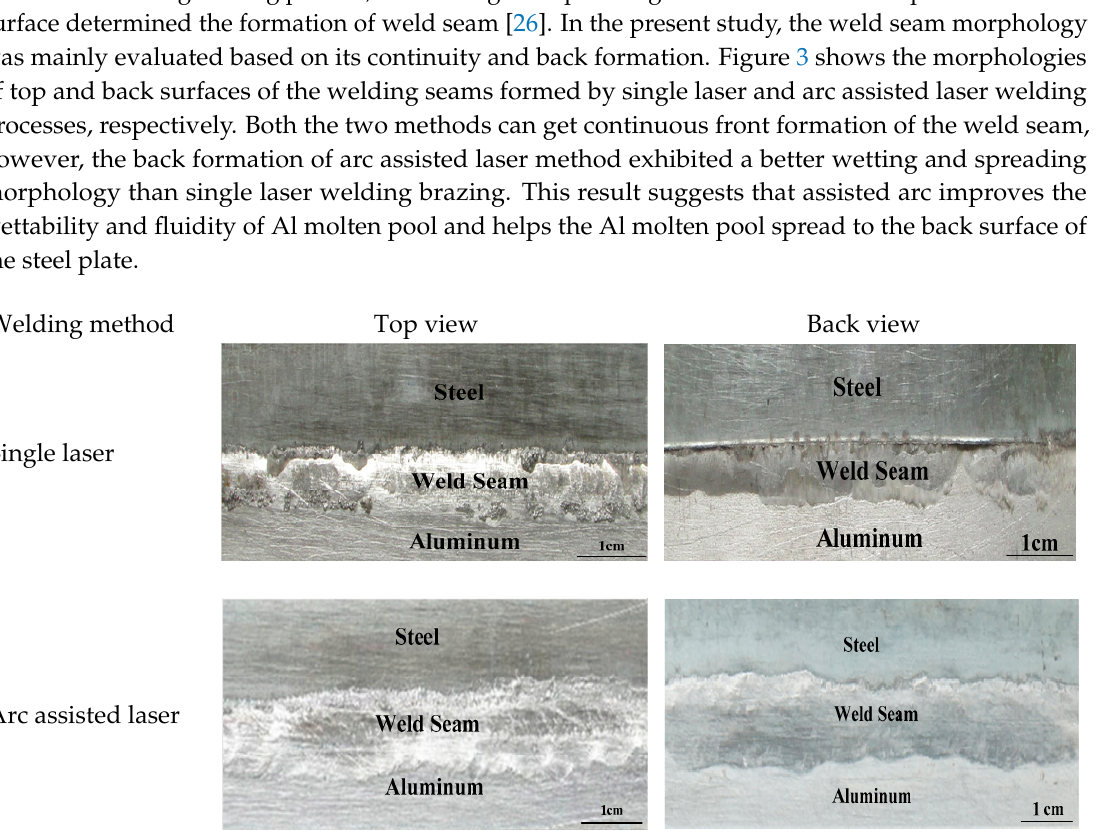
Figure 3. Surface morphologies of the weld seams formed by single laser and arc assisted laser welding processes.